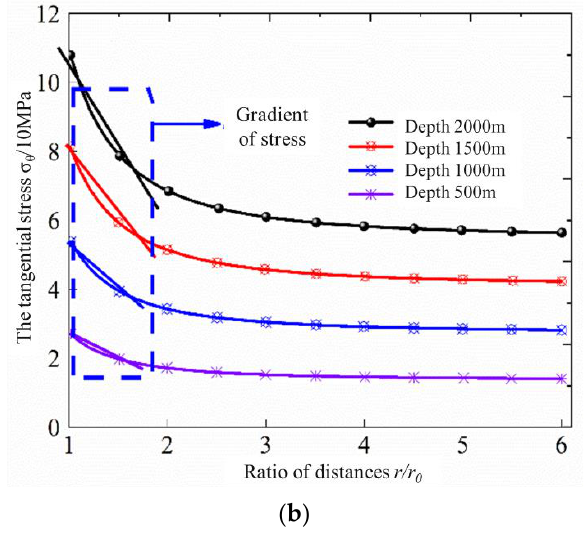
Figure 7. Distribution diagram of surrounding rock stress after roadway excavation. ( a ) The radial stress; ( b ) The tangential stress.